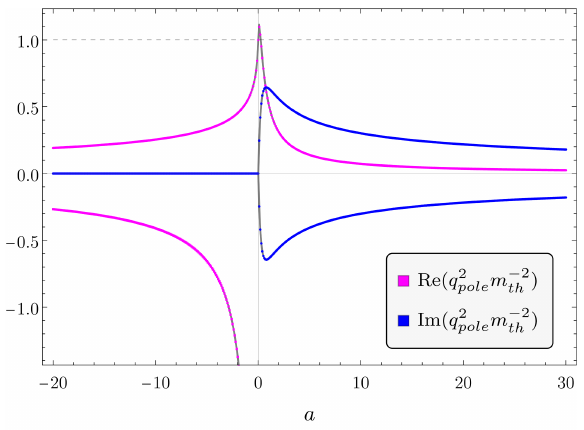
Figure 14 . Pole structure of the one-loop graviton propagator as a function of a , and for b = 1 . When the coupling a is negative, the propagator displays one stable ghost pole and one stable tachyonic ghost pole. The latter approaches infinity when a → 0 . The former splits into a pair of complex-conjugate poles when a becomes